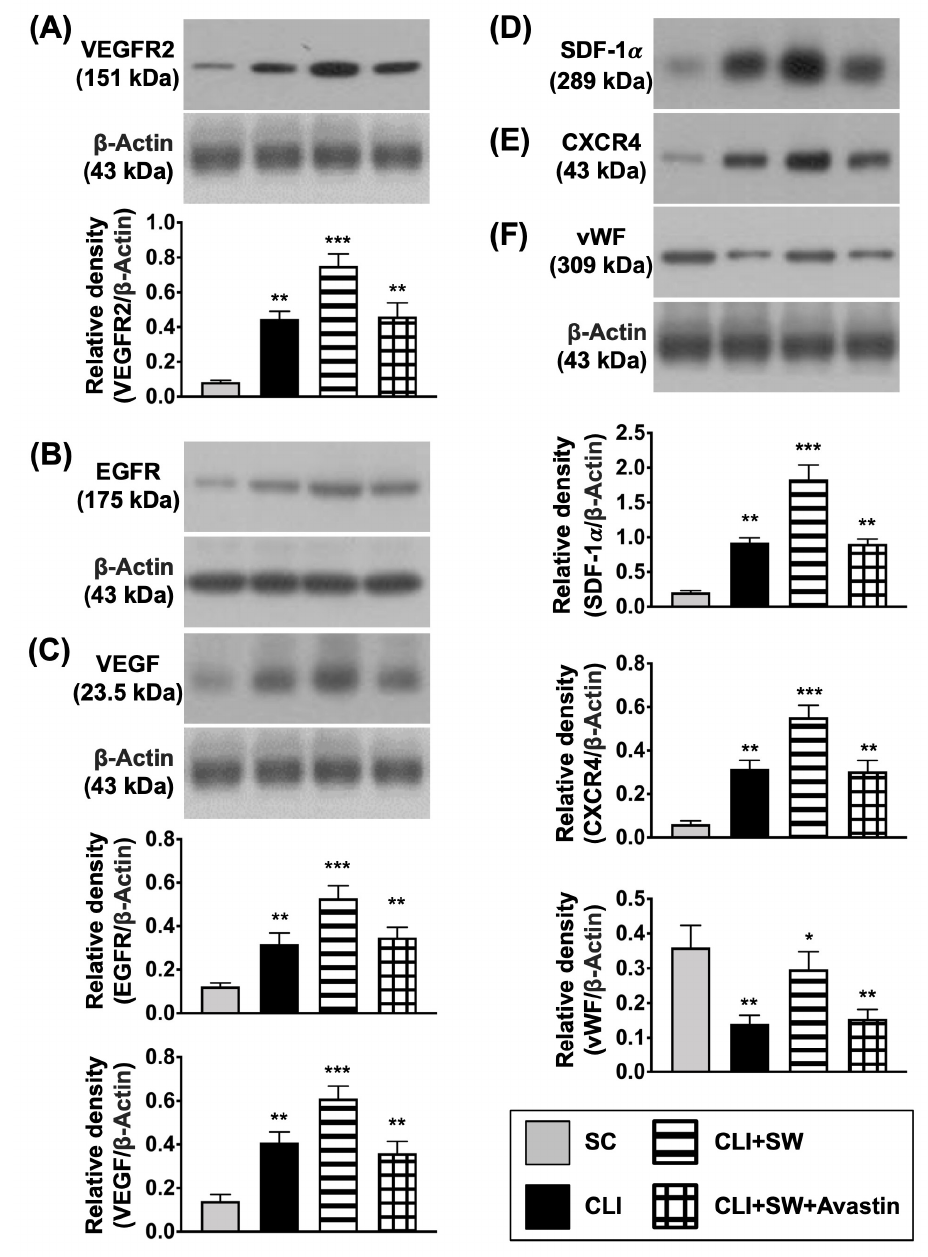
Figure 5. The protein expressions of cell growth, angiogenesis receptor and angiogenic factors in CLI quadriceps muscle by day 14 after CLI induction. ( A–F ) Western blot analyses showed the results of protein expressions of vascular endothelial growth factor receptor 2 (VEGFR2) ( A ), epidermal growth factor receptor (EGFR) ( B ), vascular endothelial growth factor (VEGF) ( C ), ( D ) stromal cell derived factor (SDF)-1 α , CXCR4 ( E ), and von Willebrand factor (vWF) ( F ), * for p < 0.05, ** for p < 0.01, *** for p < 0.001. n = 6 for each group. SC = sham-operated control; SW = shock wave.